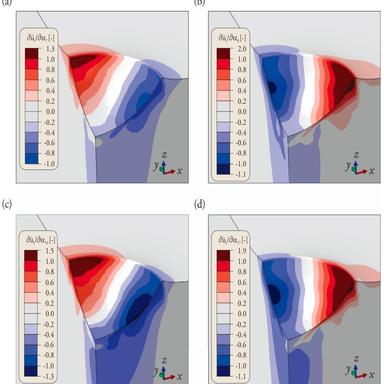
Sensitivity of vertical displacement to the change of parameters associated with the out-of-plane shear behaviour. The numerically computed sensitivity is normalised with the maximum pile-up height. As expected, perturbation of parameters results in similar extreme values of sensitivities, whereas the distributions are antisymmetric.